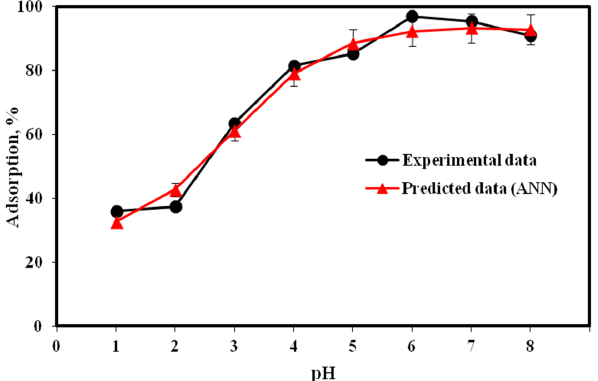
Figure 3. Aqueous pH influence on Cu(II) adsorption (adsorbent dose: 2 g/L, Cu(II) concentration: